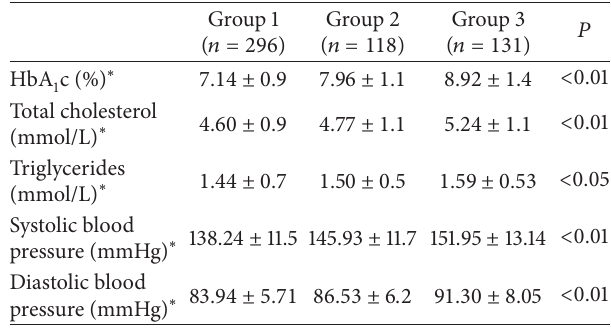
Table 3: Metabolic and clinical parameters of type 2 diabetic patients ( 𝑛 = 545 ) divided into three groups according to diabetic retinopathy